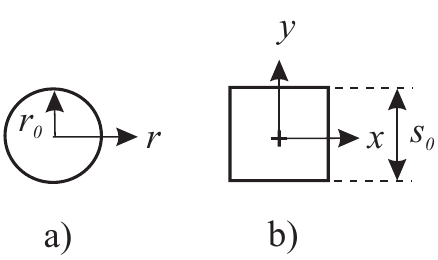
Figure 3 . Cross-sections and dimensions of a) circular and b) square